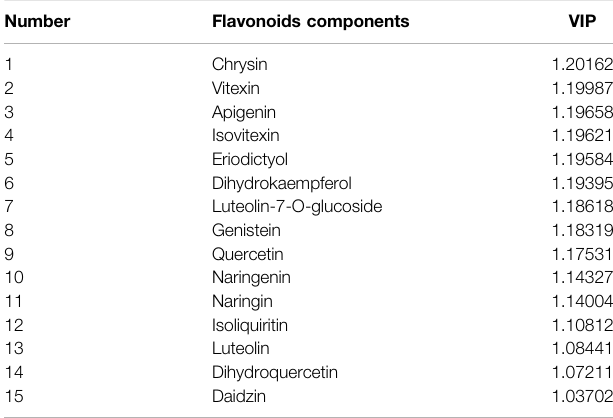
TABLE 5 | The components with variable importance in projection (VIP) values greater than one as threshold.